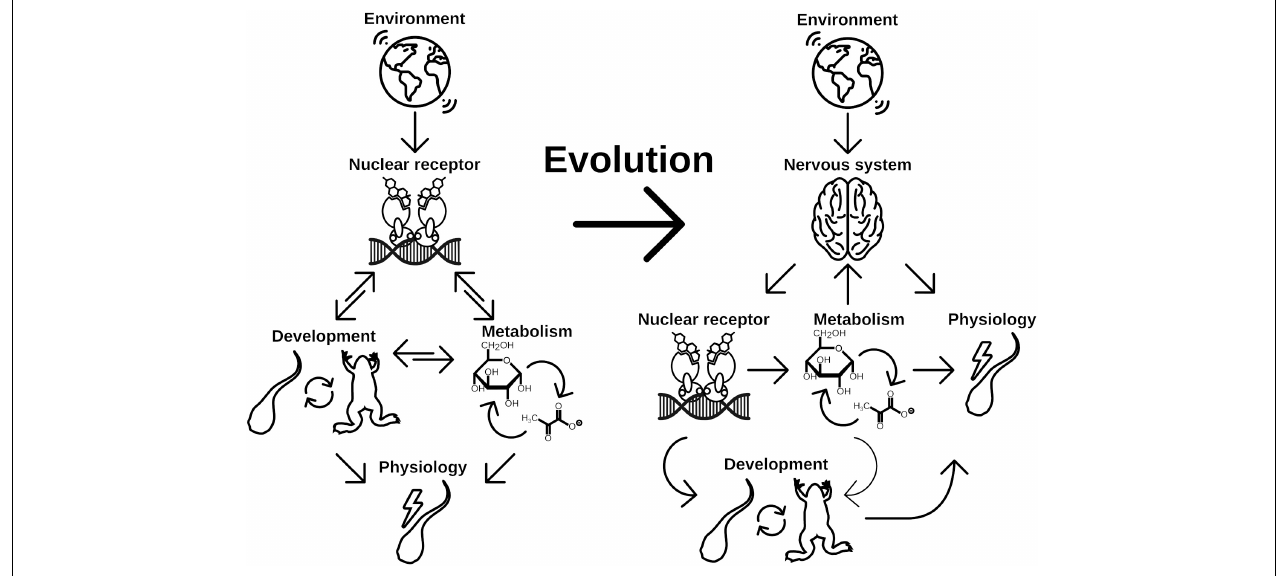
FIGURE 4 | Evolution of NRs as central point for developmental switch control is a consequence of early implementation of physiology regulation. Physiological response to different environmental cues were initially controlled by two main regulation routes, metabolism and life history changes. While changes in metabolism is the immediate response to given conditions, developmental switches control the time point of ecological niche changes. Both routes might be directly controlled by NRs in early branching animals, which renders the NRs a central element for phenotypic plasticity. With evolution of the nervous system, the evolutionary constrains on the NRs for direct control of physiology has been lifted. Consequently evolution of hormone signaling was enabled, which controls developmental processes independent of direct environmental inputs. Environmental cues are recognized by the nervous system, which eventually controls hormone signaling (thus NR signaling) and at the same time is able to directly control aspects of physiology of the organism. It thus adds another layer of environmental signal processing to facilitate more fine grained and at the same time more flexible control of physiology and life history decisions, which increases the phenotypic plasticity of the